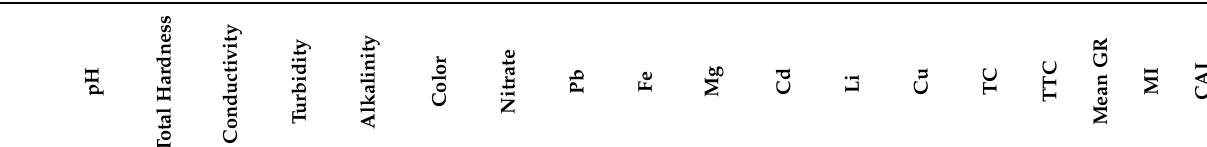
Table 6. Pearson’s correlation referring to the data of physicochemical parameters, metals and quantification of total and thermotolerant coliforms of water samples from Buritis